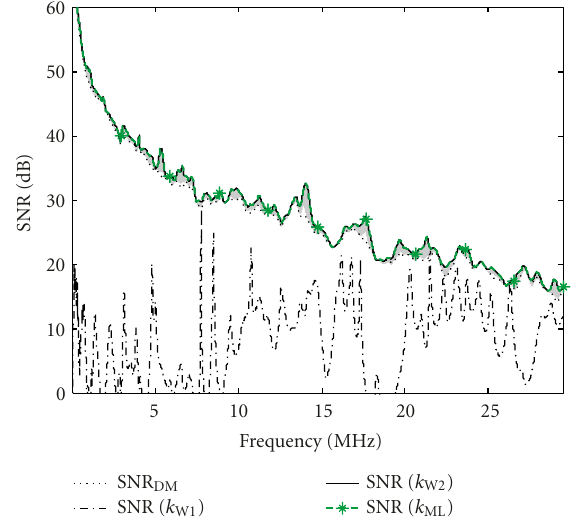
Figure 6: SNRs of adaptive cancellation compared to processing of DM signal only for a transmission over a loop of 300m length with five FEXT sources ( S = 5) located at the same distance and trans- mitting with the same PSD of − 60 dBm/Hz as the far-end transmit- ter. The background-noise level on both DM port and CM port is − 140 dBm/Hz. The grey-shaded area indicates SNR values for coef- ficient mismatch of up to 100% (SNR( K 1